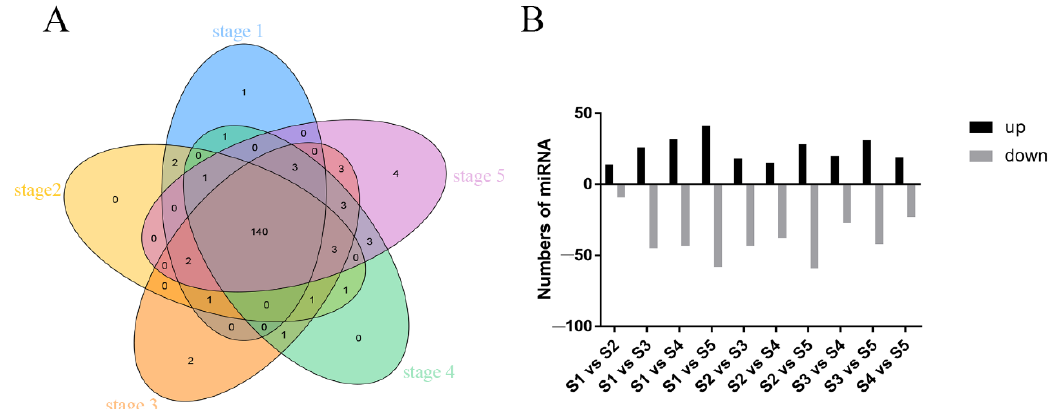
Figure 2. The expression status statistics of miRNAs from five continuous development stages. ( A ) Distribution of the 172 known miRNAs in different development stages of the receptacle. ( B ) Statistics of differentially expressed miRNAs between each two distinct stages. S1, S2, S3, S4, and S5 are the abbreviation of stages 1, 2, 3, 4, and 5, respectively.